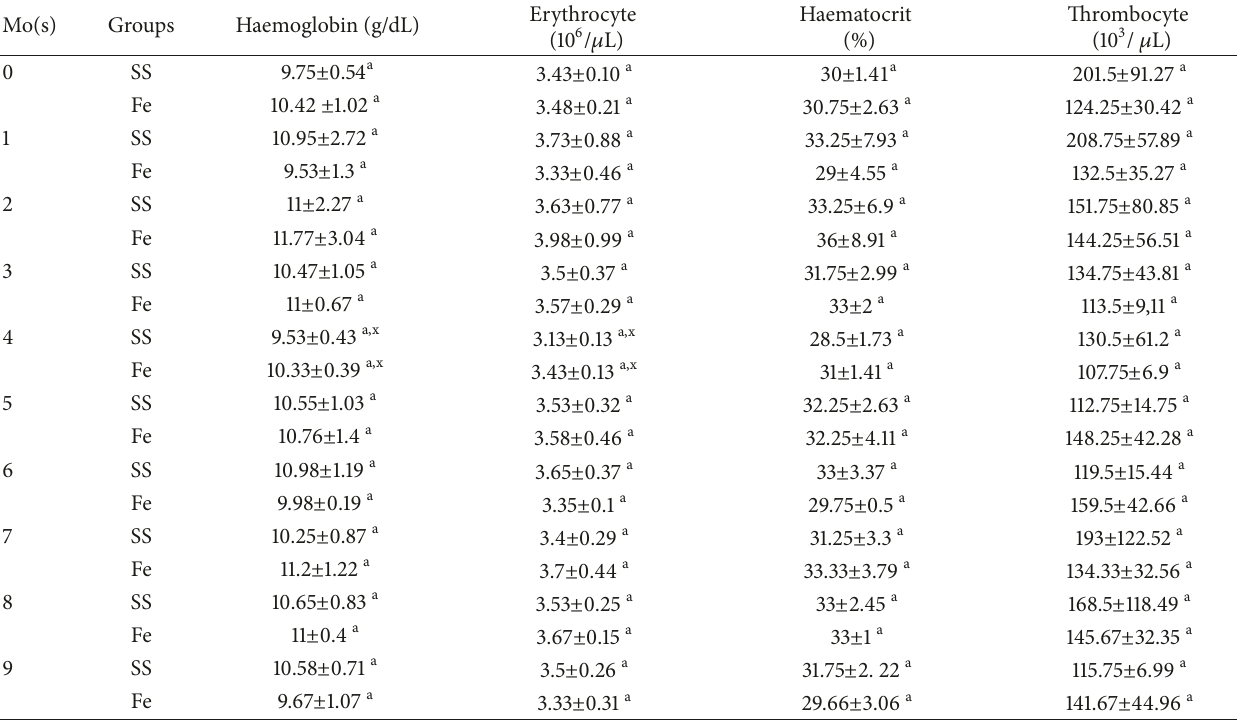
Table 1: Erythrocyte profile and thrombocyte of iron-based implant in tibia shaft fracture in month 0 until month 9 after implantation in